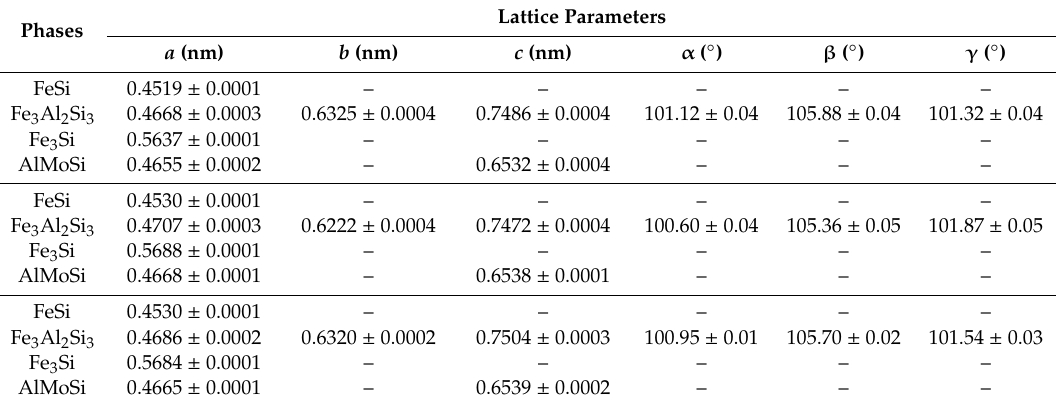
Figure 1. XRD di ff raction patterns of the mechanical alloying and spark plasma sintering (MA + SPS) FeAl20Si20-Mo-Ni (wt %) alloys containing Mo and Ni in a range from 5–15 wt %. Table 1. Lattice parameters determined by the XRD analysis of present phases identified in the MA + SPS FeAl20Si20-Mo-Ni